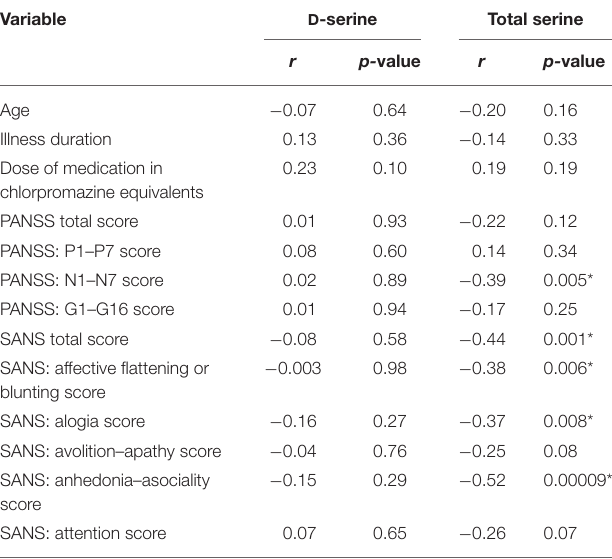
TABLE 4 | The correlations between variables and amino acid serum levels in patients ( n = 50).